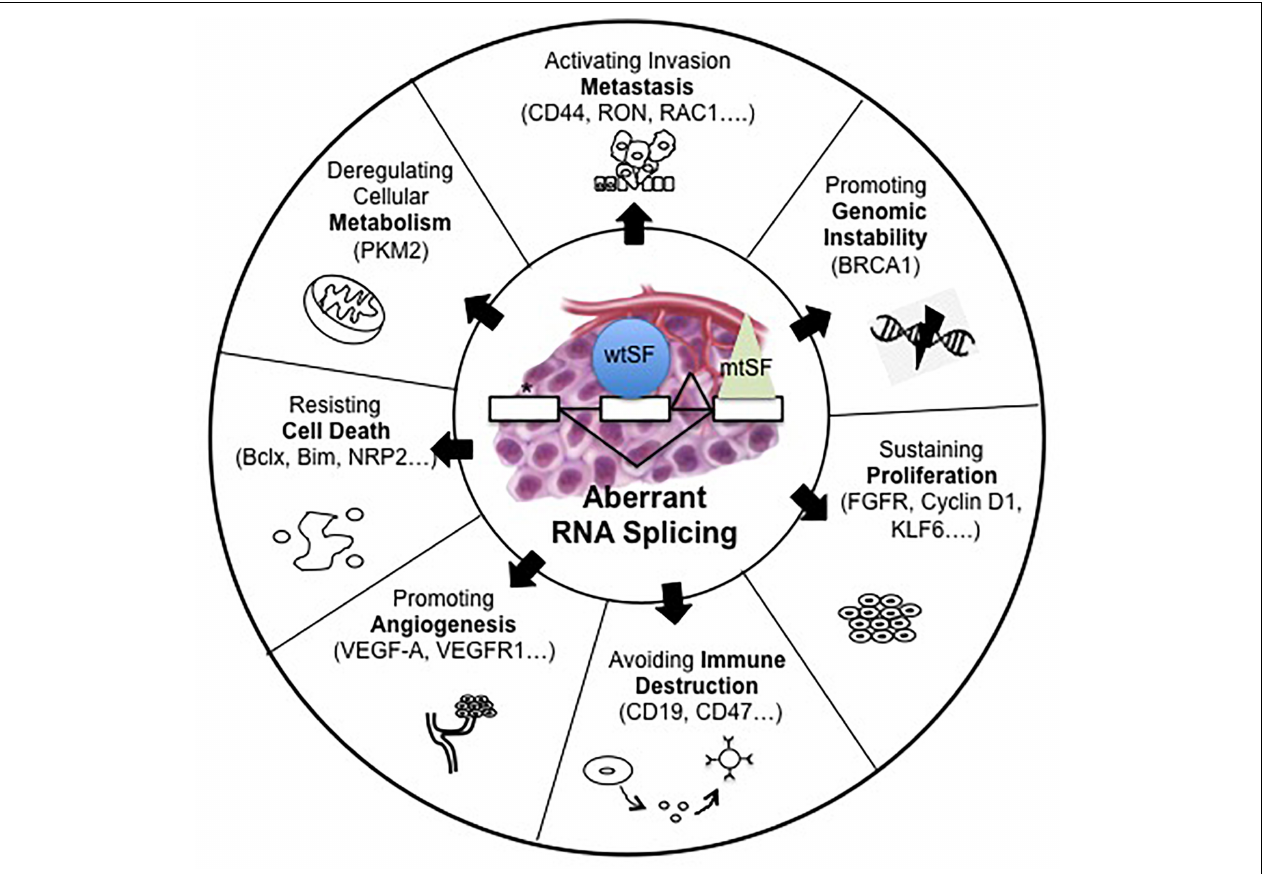
FIGURE 1 | Alterations of pre-mRNA alternative splicing in cancer. Human tumors display mutations in cis , which alter splice sites ( ∗ ) or abnormalities in trans such as somatic mutations (mtSF) or deregulated expression of splicing regulatory factors (wtSF). These alterations lead to aberrant RNA splicing of numerous downstream target genes. These abnormal splicing patterns contribute to all cancer hallmarks including genomic instability, sustained proliferation, immune escape, angiogenesis, resistance to cell death, deregulated metabolism, or metastatic